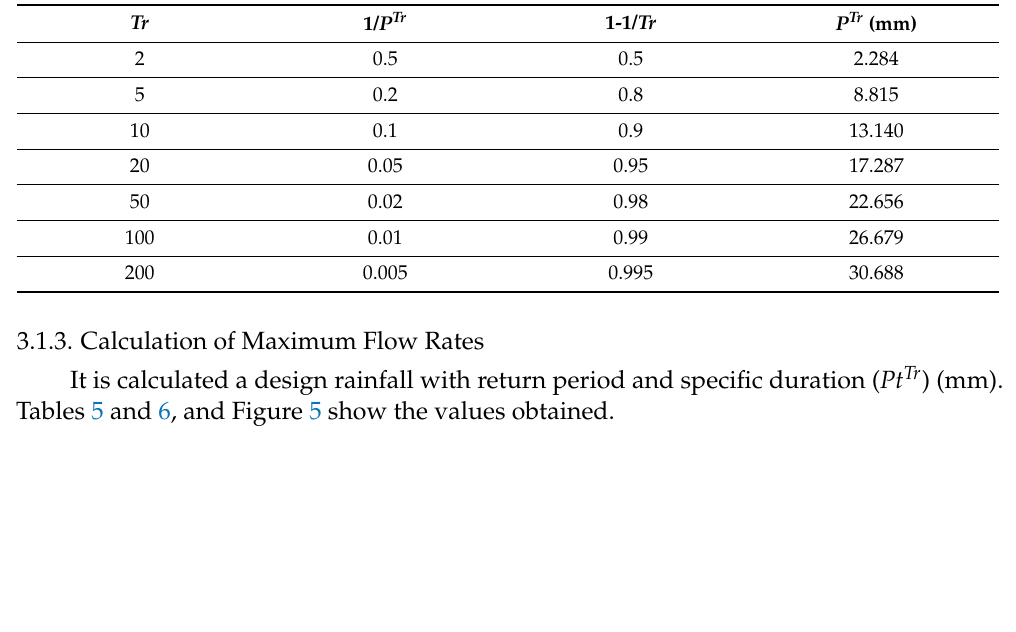
Table 4. Rainfall for different specific return periods ( Tr ). P Tr (mm) maximum daily rainfall in a return period of “ x ”